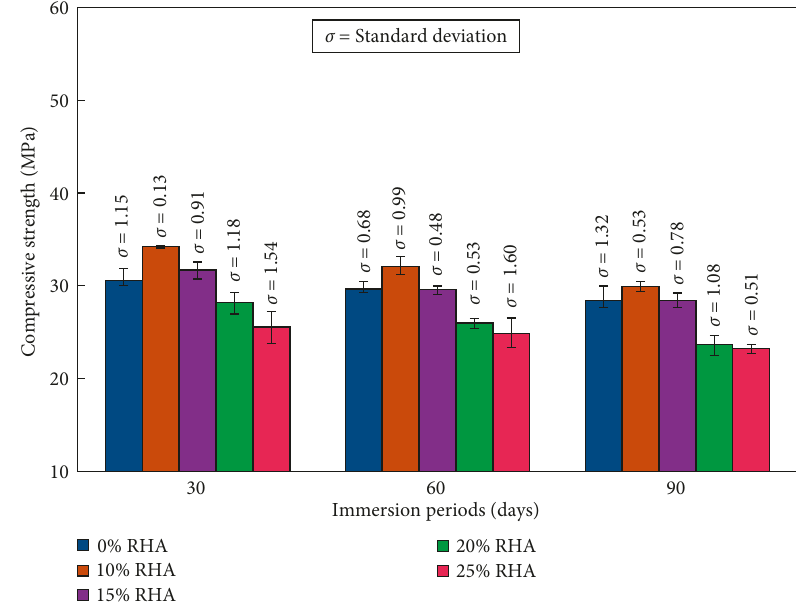
Figure 10: Compressive strength of RBAC immersed in HCl solution for 30, 60, and 90